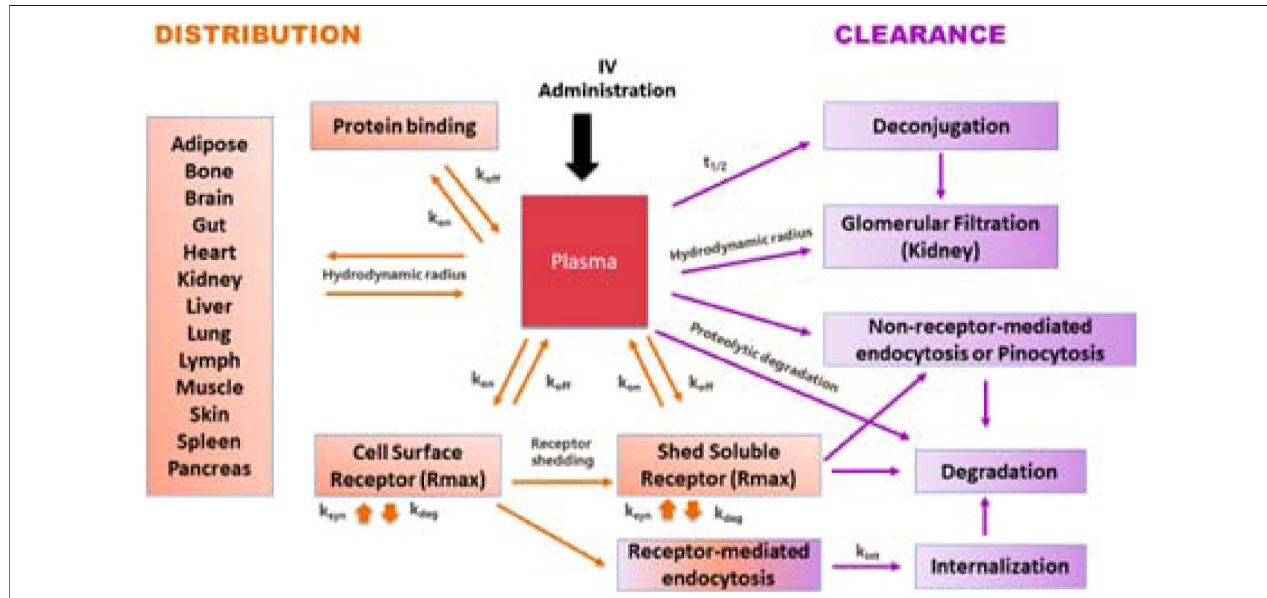
FIGURE 2 | A schematic representation of a general modeling framework incorporating key processed involved in the disposition and clearance of PEGylated cytokines.